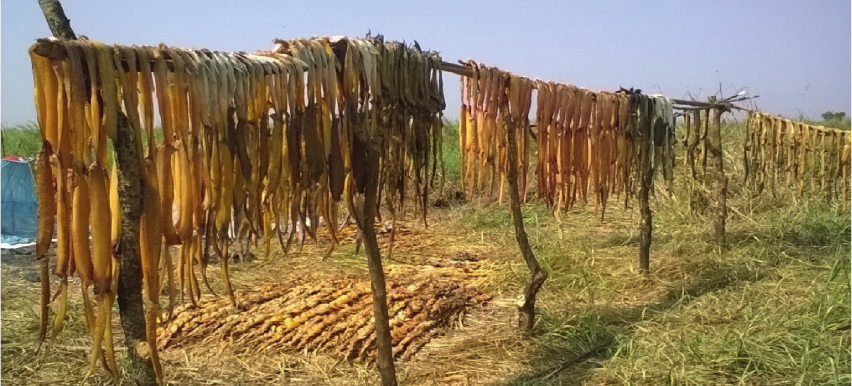
Figure 2: Fish fillets hanged for immediate sundry in Wagan wetland fishers’ camp (photo by Gatriay Tut).